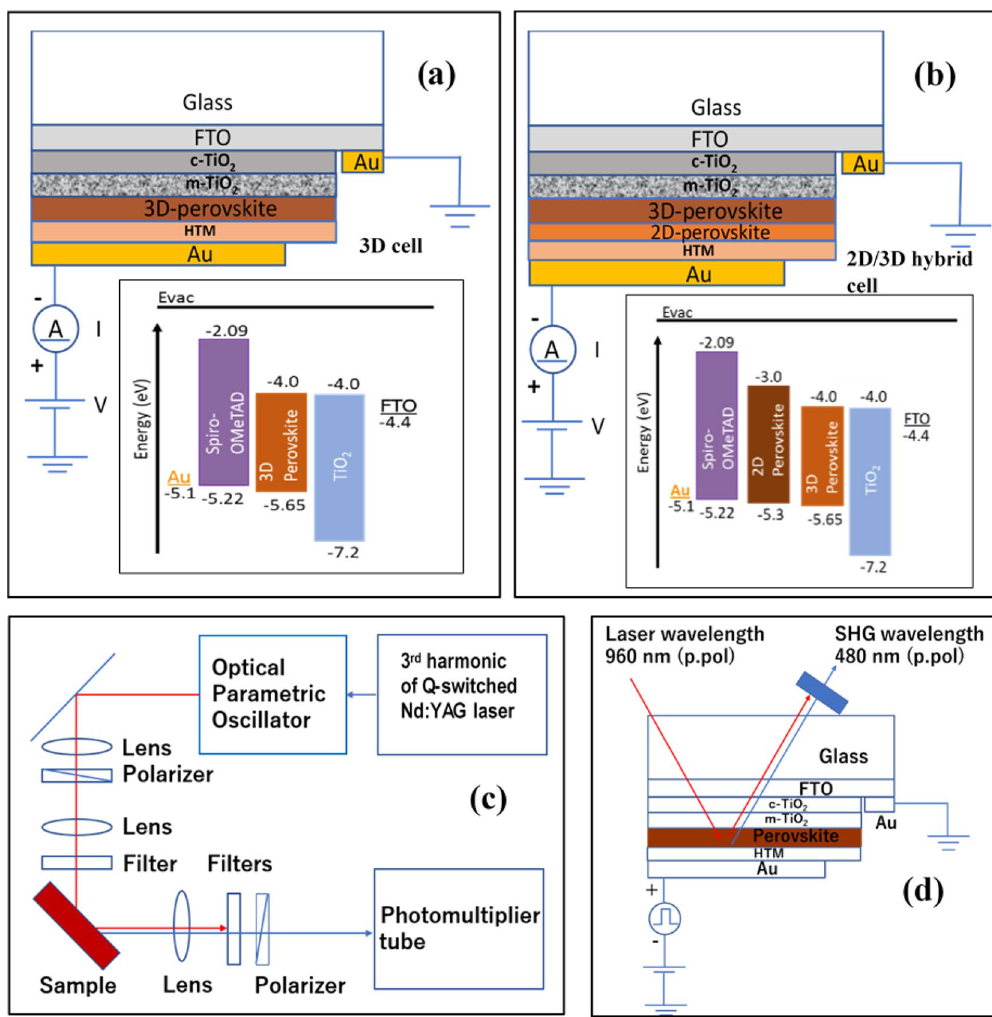
Figure 1. Device diagrams and schematic of the connection during the measurements. (a) 3D samples and (b) 2D/3D hybrid samples. The insets show the energy band-gap diagram of perovskite solar cells (PSCs). (c) shows the schematic of the EFISHG measurement system used to analyze both types of the samples, and (d) gives the illustration of the orientation of the 3D samples (a similar setup was used for the 2D/3D hybrid